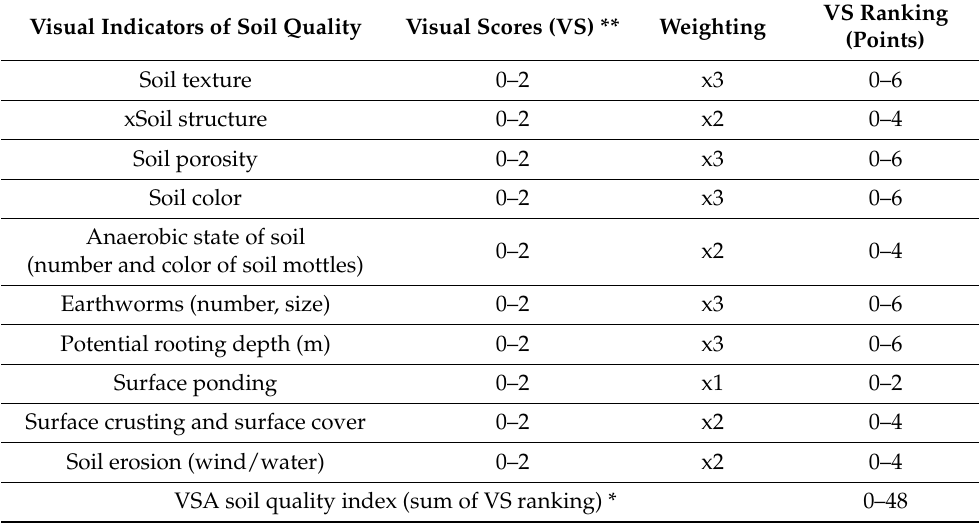
Table 1. List of visual indicators for the visual soil assessment (VSA) of soil quality in annual crops [15]. Visual Indicators of Soil Quality Visual Scores (VS) ** Weighting